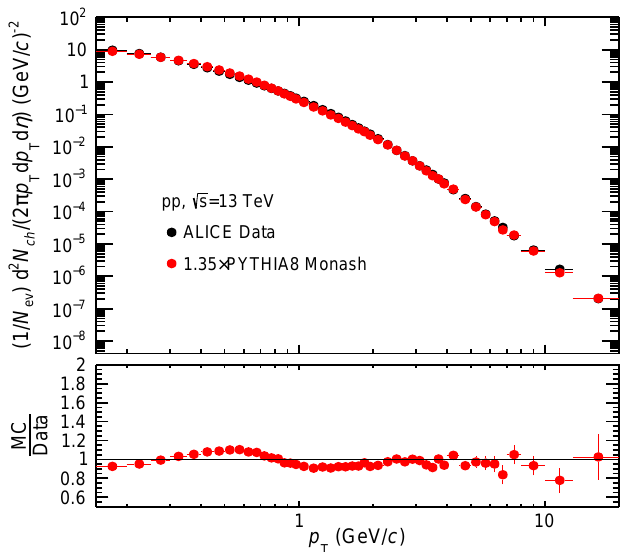
√ s = 13 TeV between